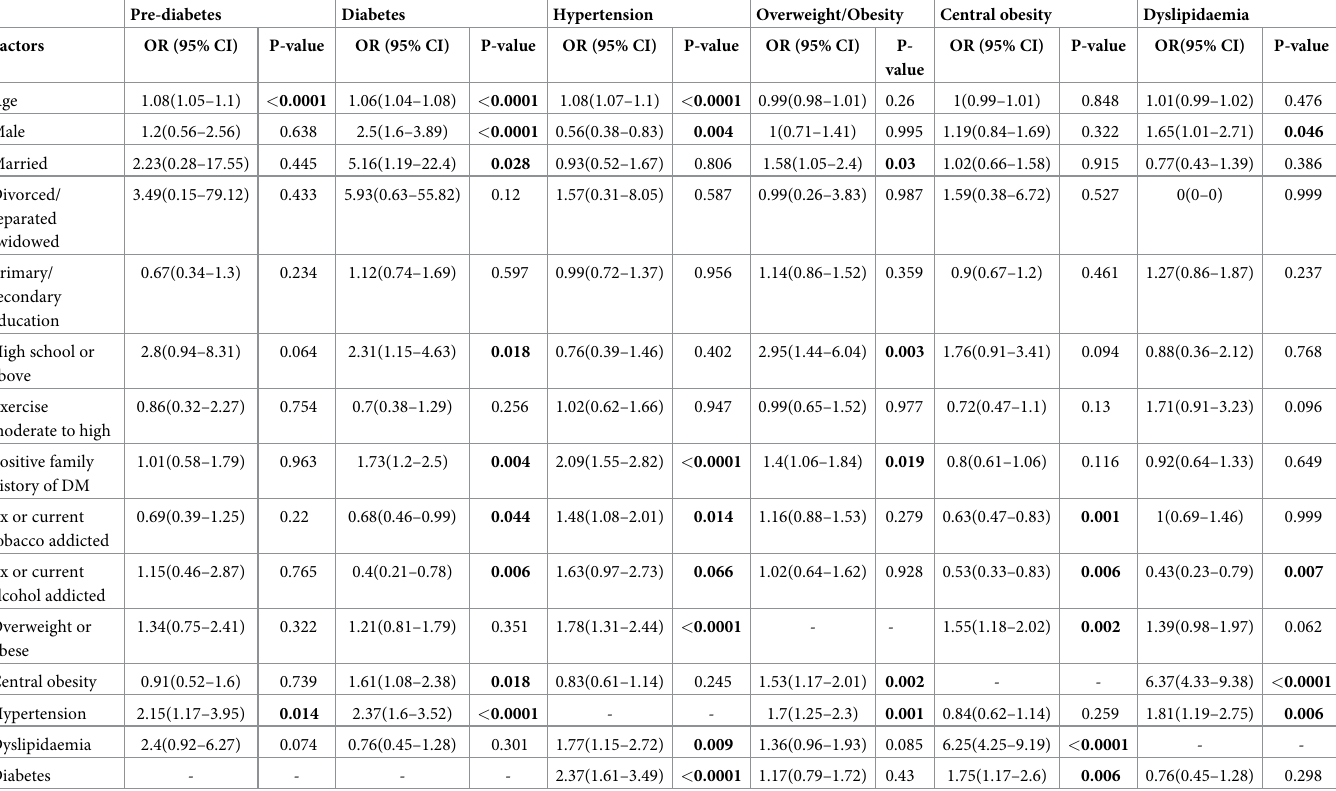
Table 3. Adjusted odd ratios of potential risk factors associated with